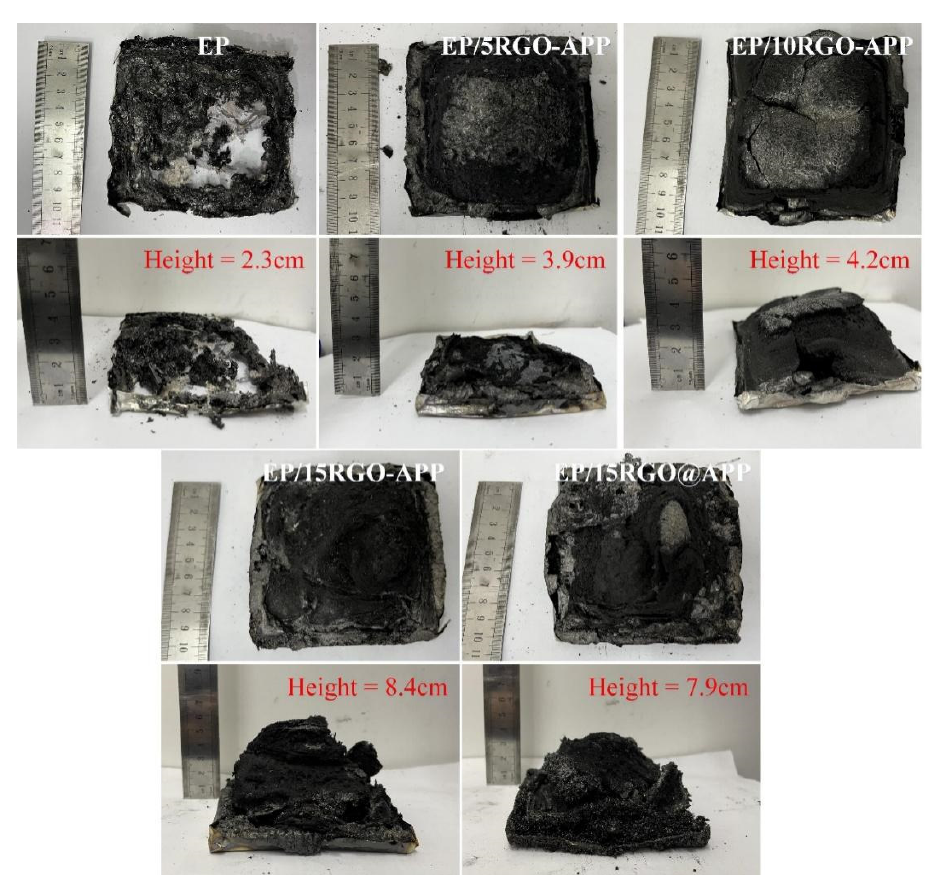
Figure 9. The top view and side view of the char layer of pure EP and flame-retardant EP after the